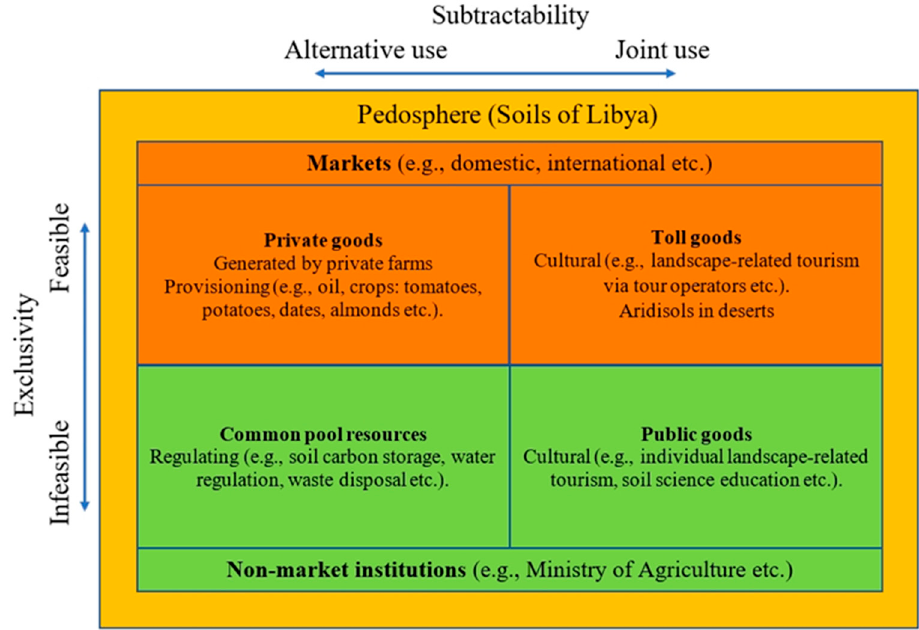
Figure 15. Examples of activities and ecosystem services derived from Libyan soil resources (modified from [79]).